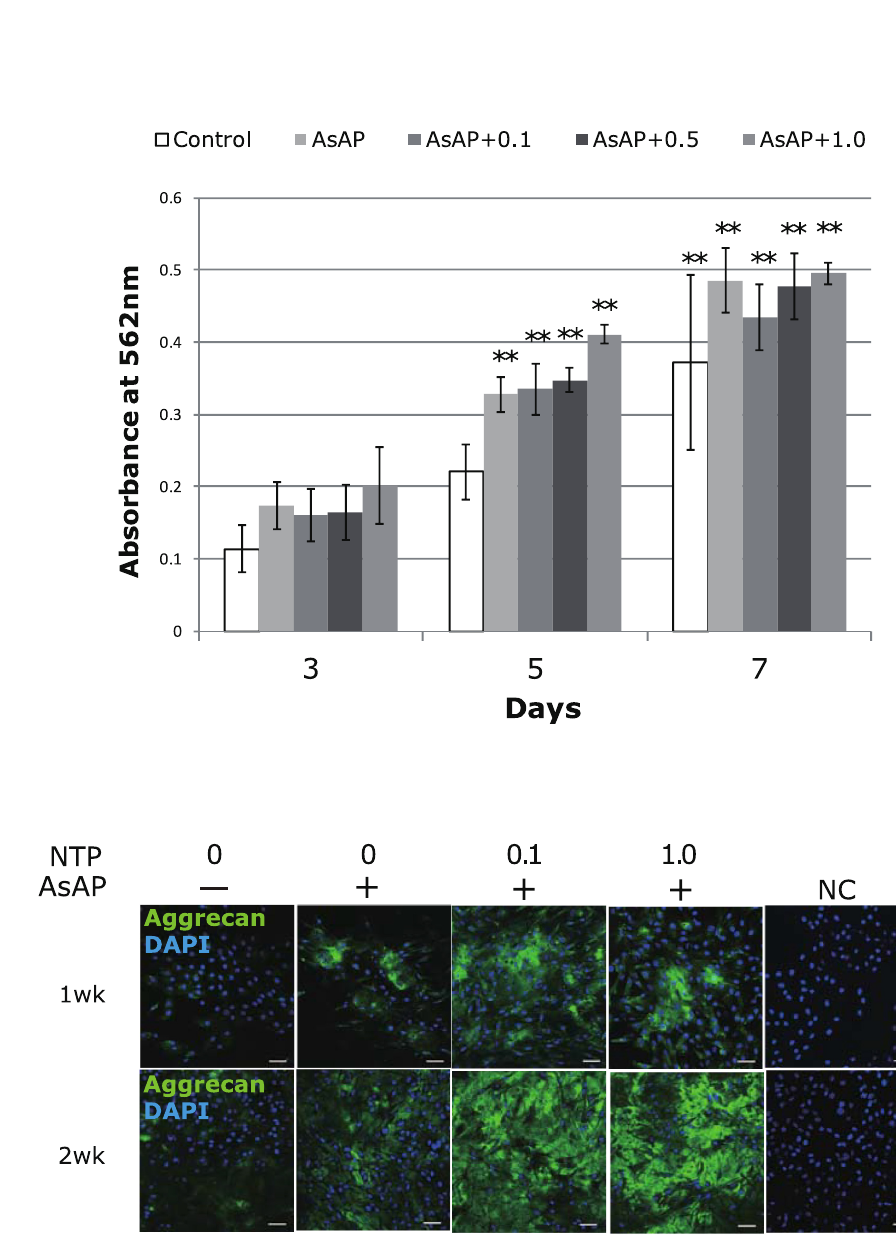
Fig 1. Effect of Neurotropin (NTP) on cellular growth and aggrecan synthesis. A) NP cells seeded in 96-well plates were cultured in 10% FBS α -MEM supplemented with 0, 0.1, 0.5, or 1.0 mNU/ml NTP with 50 μg/ml L-ascorbic acid-2-phosphate (AsAP). Cell proliferation was evaluated using the MTT assay on days 3, 5, and 7 after treatment, and values are shown as absorbance at 562 nm. Cell proliferation was enhanced on days 5 and 7 by either addition of AsAP or cotreatment with AsAP and NTP, compared with untreated cells on day 3. Data are presented as the average ± standard error ( (cid:3)(cid:3) p < 0.01, N = 3). B) Immunofluorescence staining of aggrecan in NTP-treated NP cells. Cells were seeded at a density of 3x10 3 cells /cm 2 on glass chamber slides and cultured with NTP. After two weeks of culture, expression of aggrecan core protein increased in the NTP-treated cultures compared with untreated cultures or those treated only with AsAP. Representative images are shown. Green indicates aggrecan, and nuclei are shown in blue by staining with 4 0 ,6-diamidino-2-phenylindole dihydrochloride (DAPI). NTP concentrations of 0.1 and 1.0 mNU/ml were used. Bars are 50 μm.